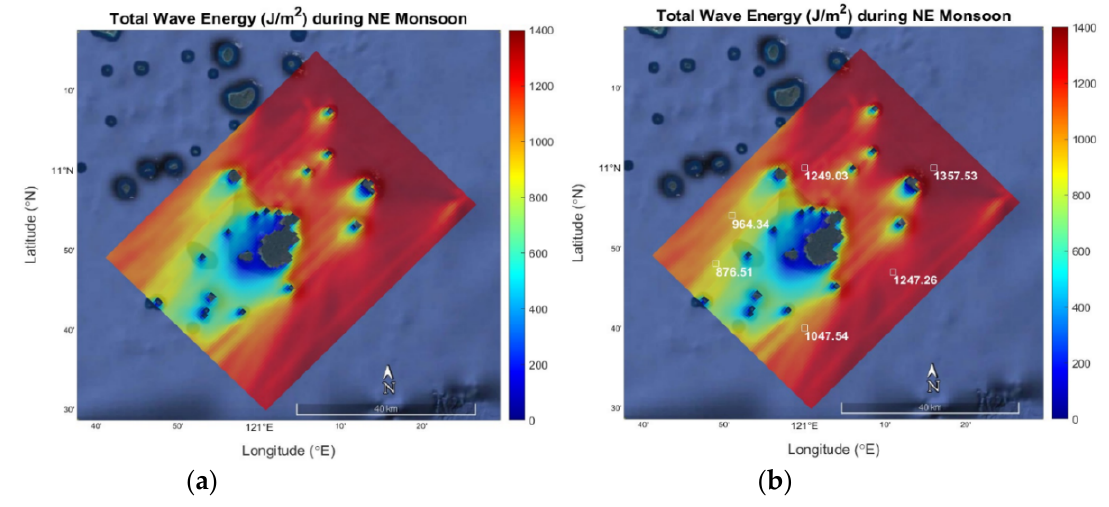
Figure 17. ( a ) Wave energy propagation (J/m 2 ) model during northeast monsoon season and ( b ) wave energy propagation model, indicating the total wave energy propagated and indicating the average period at stations A–F.